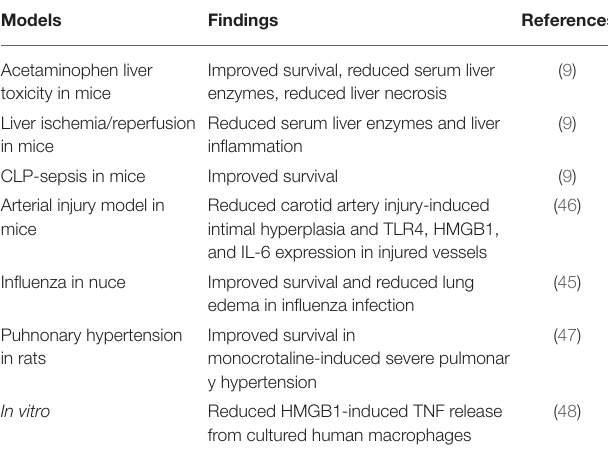
TABLE 1 | Summary of efficacy of P5779 in HMGB1-driven inflammatory